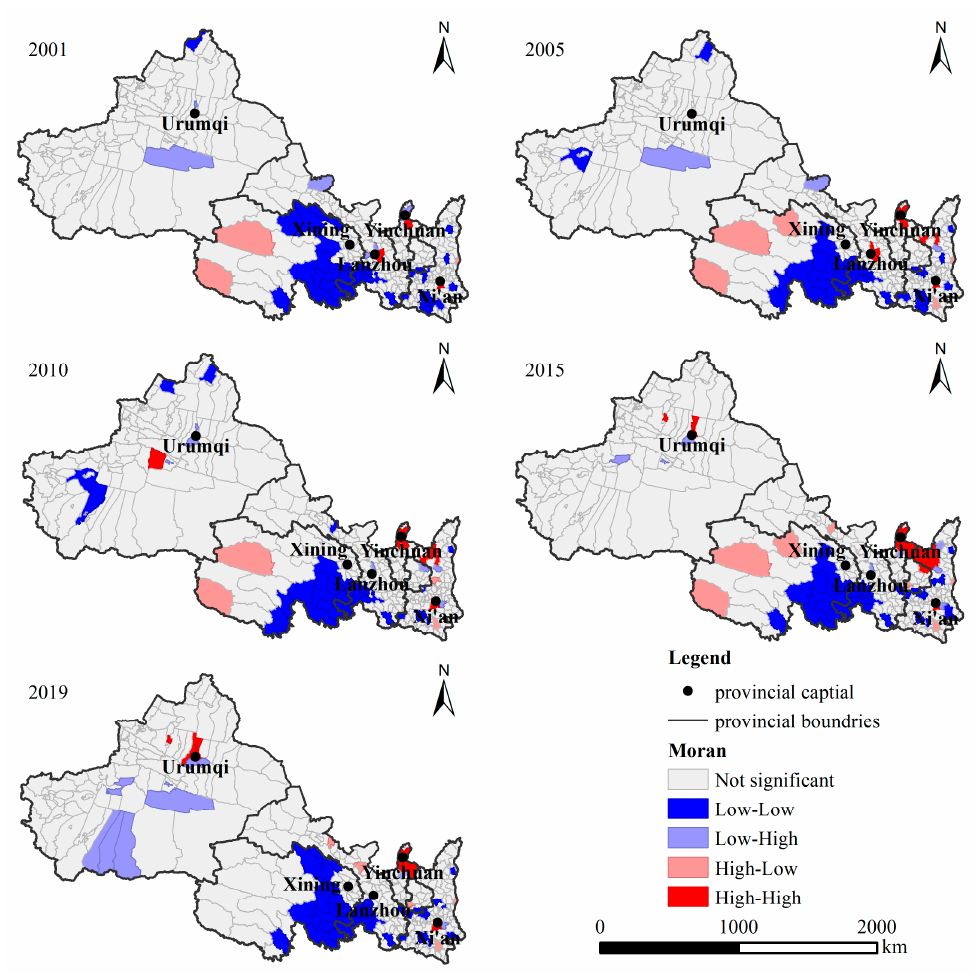
Figure 6. Spatial pattern of LISA of CE in northwest China at the country level from 2001 to